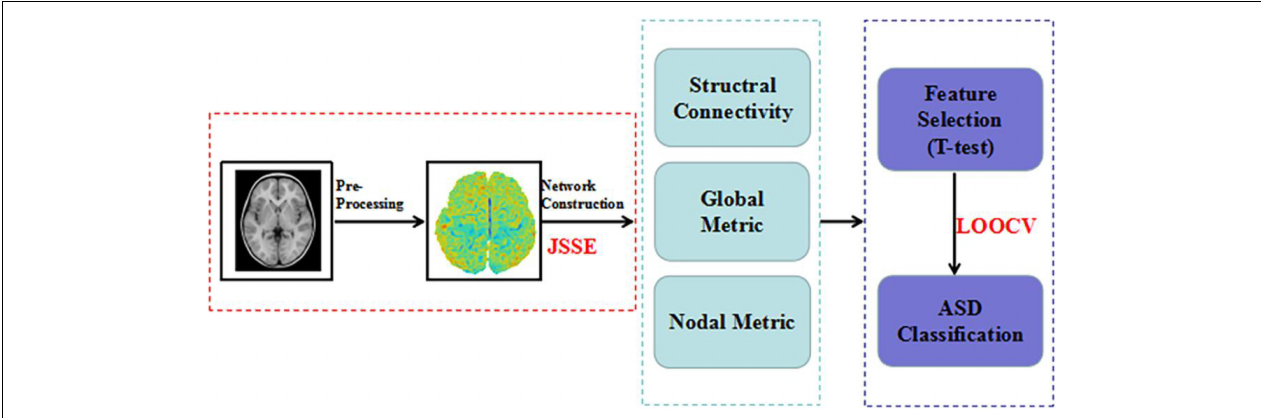
FIGURE 1 | Data processing and